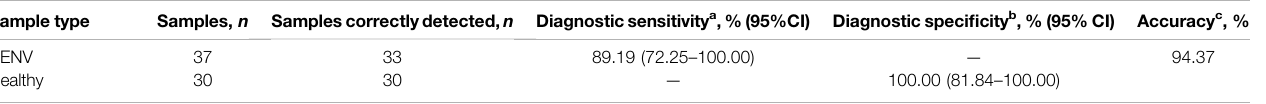
Supplementary Table S1 describes the detailed results. CI, con fi dence interval; DENV, dengue virus; MFEA, magnetic fi eld-enhanced agglutination. a [number of positive samples/(number of positive samples + number of false-negative samples)] × 100. b [number of negative samples/(number of negative samples + number of false-positive samples)] × 100. c [(number ofnegative samples + number of positive samples)/(numberofnegative samples + number of positive samples + number of false-negative samples + number offalse-positive samples)] ×